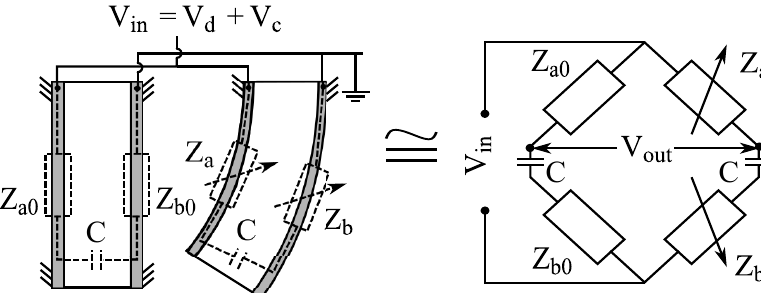
Figure 14. Principle of passive sensing and SSA methods that connect IPMCs into Wheatstone bridge configuration